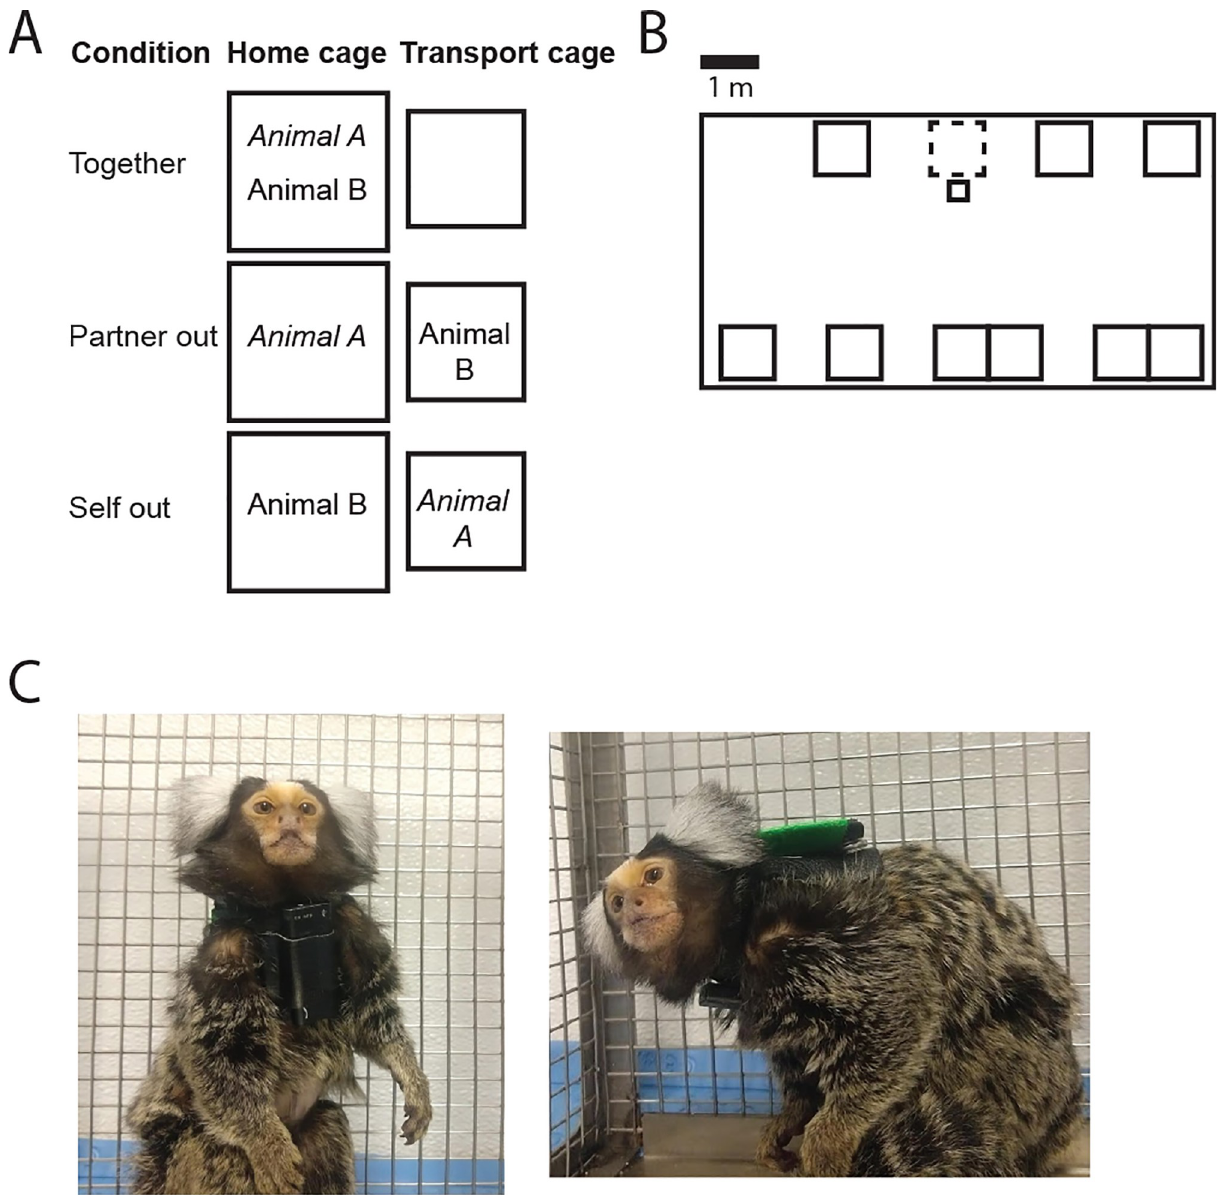
Fig 1. A . Illustration of the experimental conditions with Animal A as the focal animal. B . A cartoon example of a typical room layout and positioning of the cages. The large rectangle is the room and the small rectangles represent cages. Each single cage has two marmosets. For families, two single cages are connected to make one large cage. The cage with dashed line is the home cage recorded from. The transport cage is in front of the home cage. During separation, one animal was placed in the transport cage. C . Photos of a marmoset wearing a jacket with a voice recorder mounted at the chest. The green patch on the back is for video identification